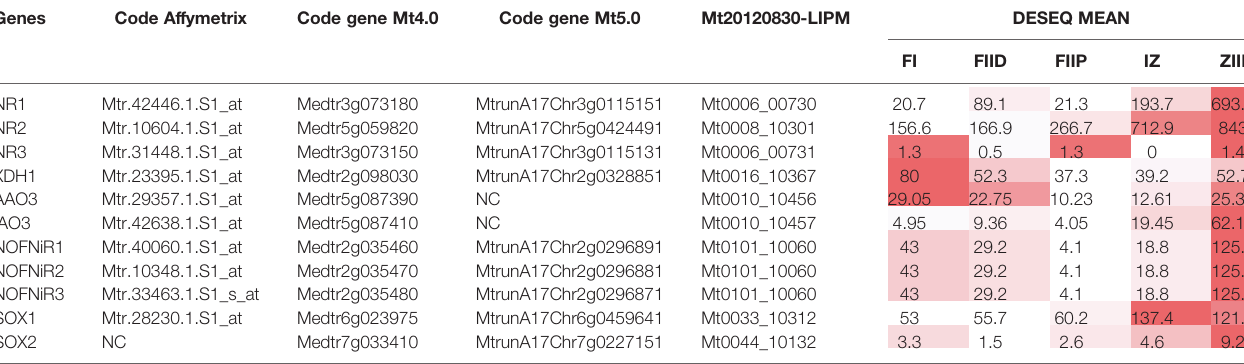
TABLE 1 | Access code and Symbimics expression of Medicago truncatula NR and NO-producing enzyme genes. Genes